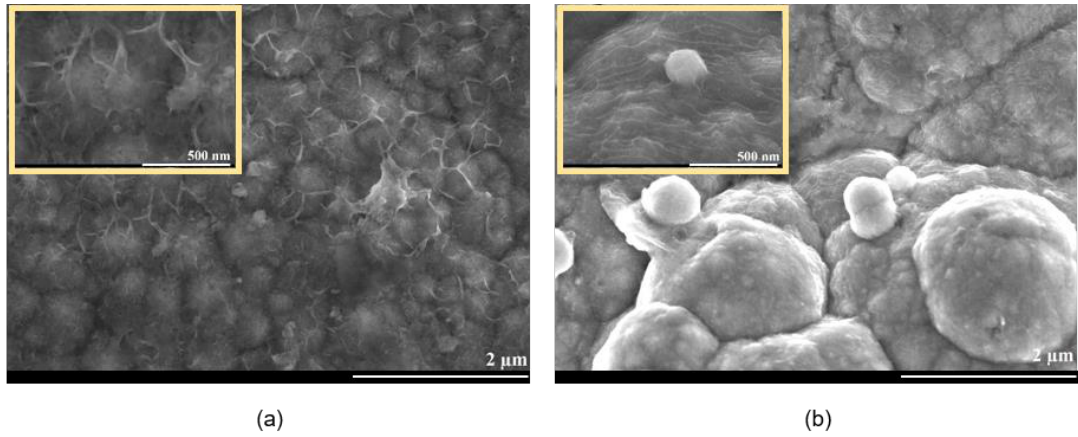
Figure 17. SEM SE micrographs of ( a ) NiSn-P3.3 alloy and ( b ) NiSn-rGO-P3.3 composite after 336 h of immersion in 0.5 M NaCl.